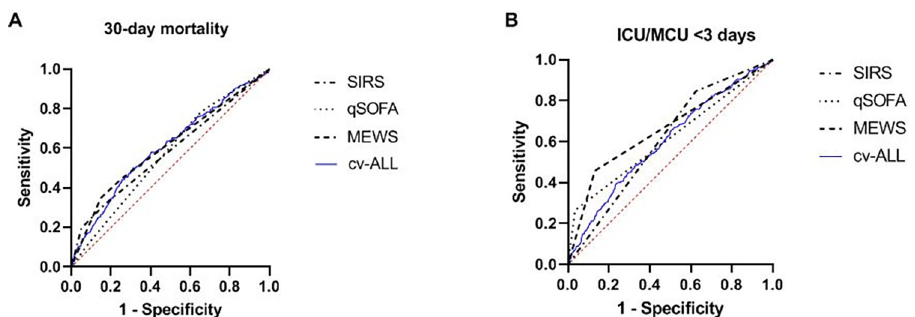
Fig 1. ROC curves to predict 30-day mortality (A) and ICU/MCU admission < 3 days after ED presentation (B). The AUC of cv-ALL of monocytes to predict 30-day mortality (AUC = 0.61) was higher than the AUC of the clinical scores SIRS (AUC = 0.57) and qSOFA (AUC = 0.57), and comparable to MEWS (AUC = 0.61). For the prediction of ICU/ MCU admission the AUC of cv-ALL of monocytes (AUC = 0.60) was slightly lower than the AUC of the clinical scores: SIRS (AUC = 0.61), qSOFA (AUC = 0.62), and MEWS (AUC = 0.66). https://doi.org/10.1371/journal.pone.0270858.g001 2.07 (95% CI 1.86–2.29, Table 2). The AUC for cv-ALL of monocytes was lower than for SIRS, qSOFA, and MEWS (AUC 0.60 vs 0.61 vs 0.62 vs 0.66 respectively, Fig 1B, Table 3). Again, cv- ALL of monocytes added significantly to the model performance of each clinical score (Table 3). In multivariable regression analysis cv-ALL of monocytes, age, sex, CCI, respiratory rate, systolic blood pressure, Glasgow Coma Scale, heart rate, white blood count and body tem- perature were independent predictors for ICU/MCU admission < 3 days after ED presenta- tion. The maximum AUC for this model was 0.81 (Fig 2B), with calibration curve shown in S4 Fig (R 2 = 0.220; Brier score = 0.070). Unlike for our primary outcome, CCI was negatively cor- related with ICU/MCU admission, meaning a higher CCI was associated with a lower chance of being admitted to the ICU/MCU < 3 days.